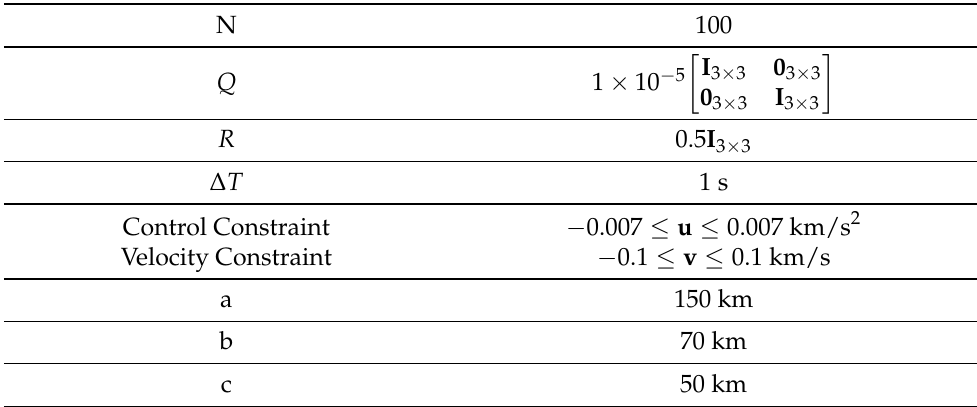
Table 3. NMPC parameters for Case 2 for asteroid